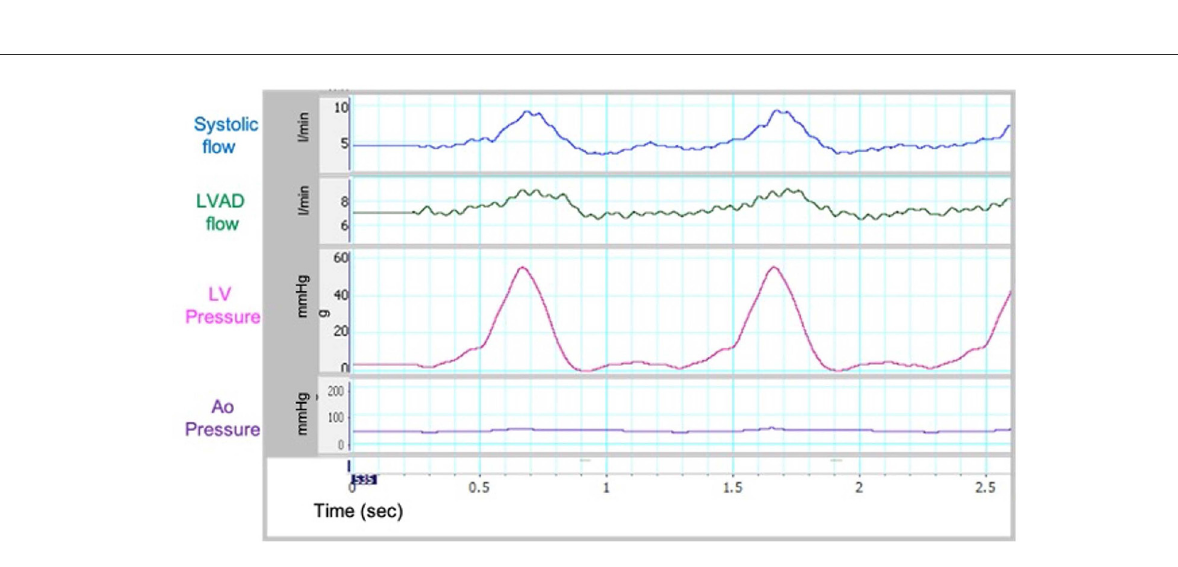
FIGURE2 Flow and pressure curves from flow